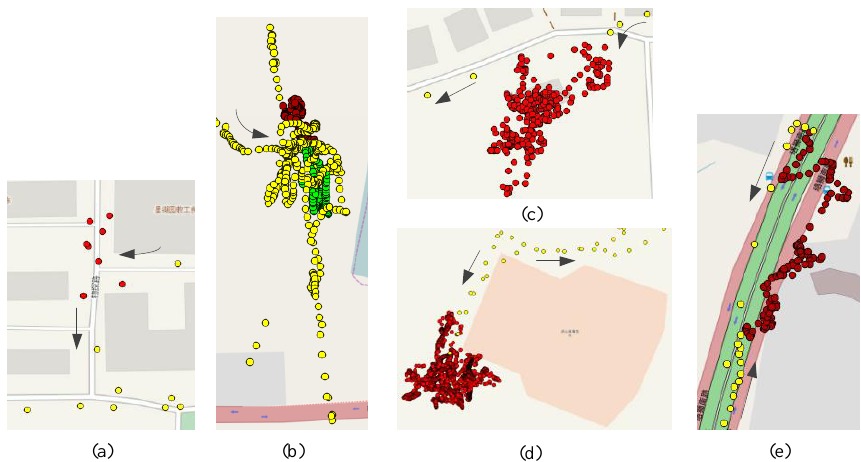
Figure 6. Cases of: ( a ) an effective stop of short indoor stay, detected without merging; ( b ) a separated stop of long indoor stay; ( c ) an effective stop of outdoor wandering, merged by Criterion 1; ( d ) an effective stop of indoor fitness, merged by Criterion 2; and ( e ) a false positive stop of a slow U-turn under a viaduct.